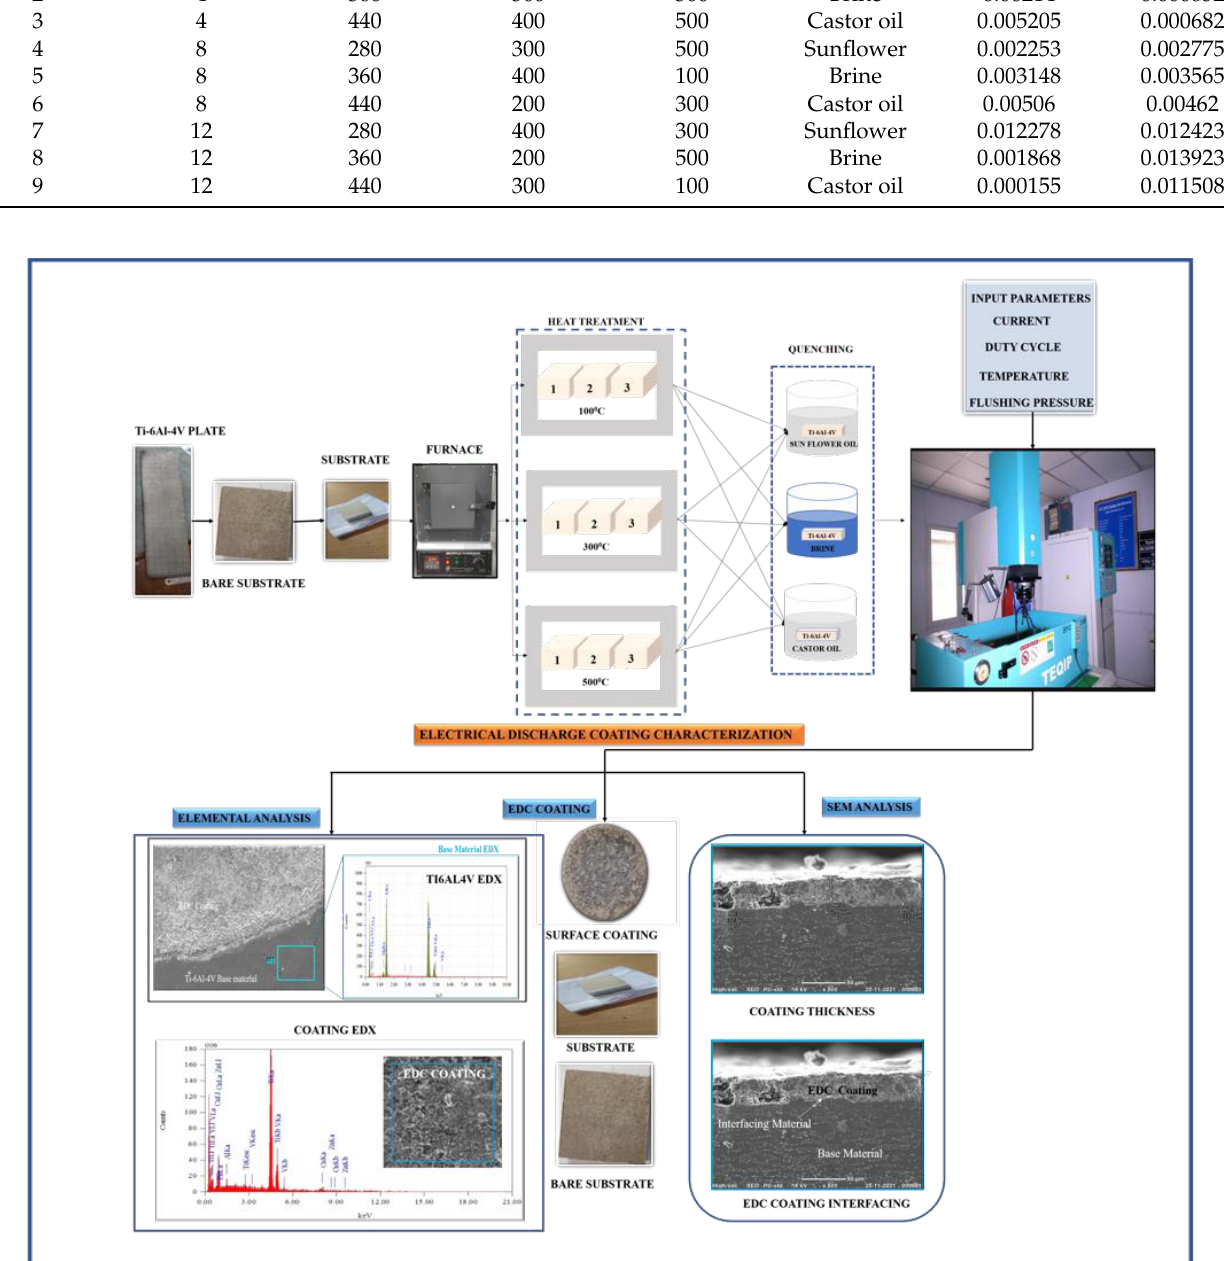
Figure 1. EDC Process Flowchart.